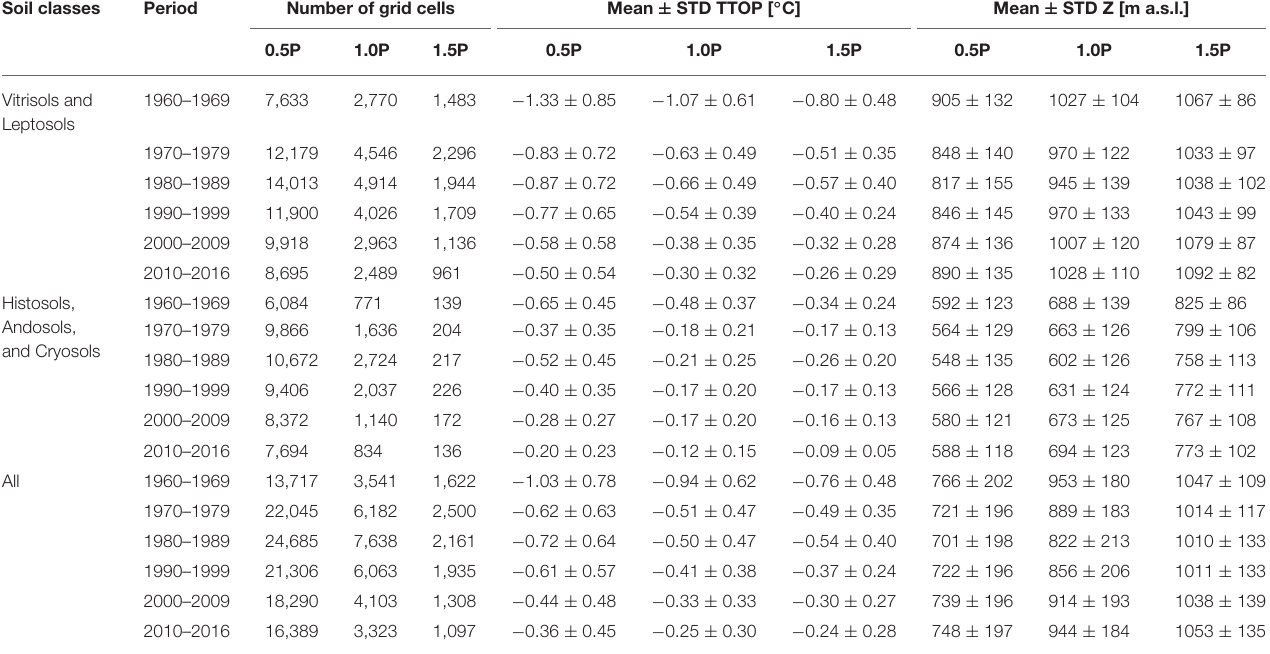
We note that in the period 1960–1969 the results seem to be strongly influenced by the model behaviour in its initialization period.